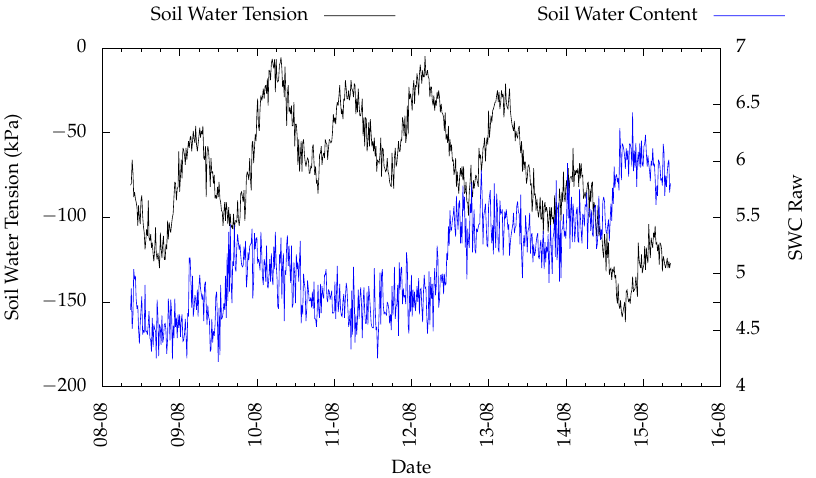
Figure 12. Steam data from FloraPulse sensor.